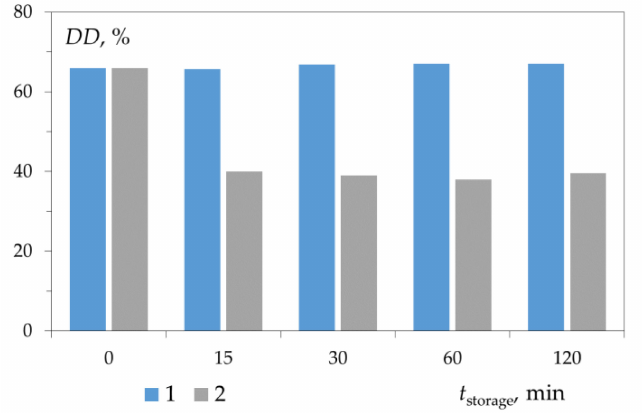
Figure 10. Dependence of the degree of deacetylation on the duration of preliminary exposure of chitin in 50% NaOH solution (1) and in water (2) at 20 ◦ C. Deacetylation: T = 100 ◦ C, τ = 30 min, DD0 = 18.7%. Original